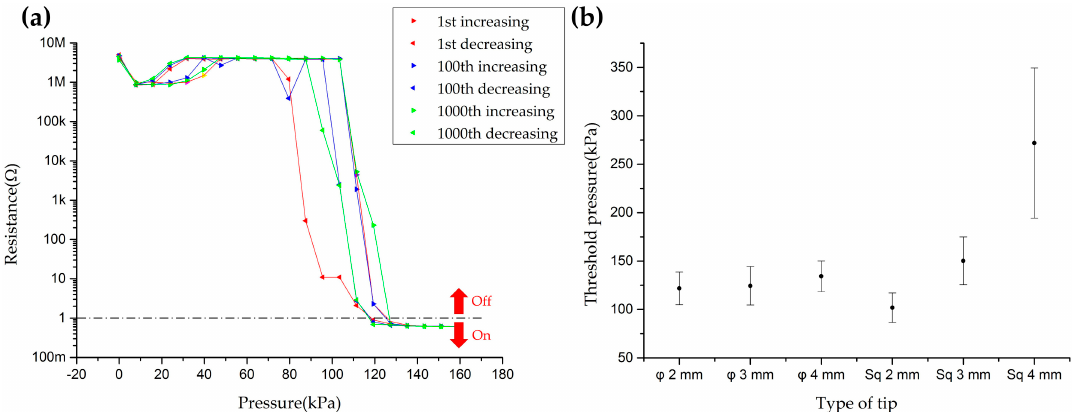
Figure 5. Performance of the sensor with a 1 mm diameter hole; ( a ) Resistance of a sensor versus pressure during 1000 exerting/releasing cycles with a circular-shaped flat Ø 4 mm tip; ( b ) Threshold pressures which are measured by various sizes of circular-shaped and square-shaped tips.